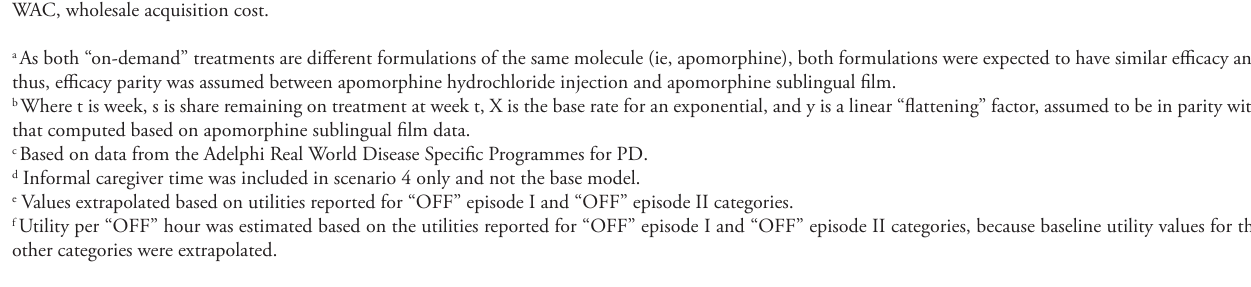
Table 2. Cost-Effectiveness Analysis Model Inputs Model